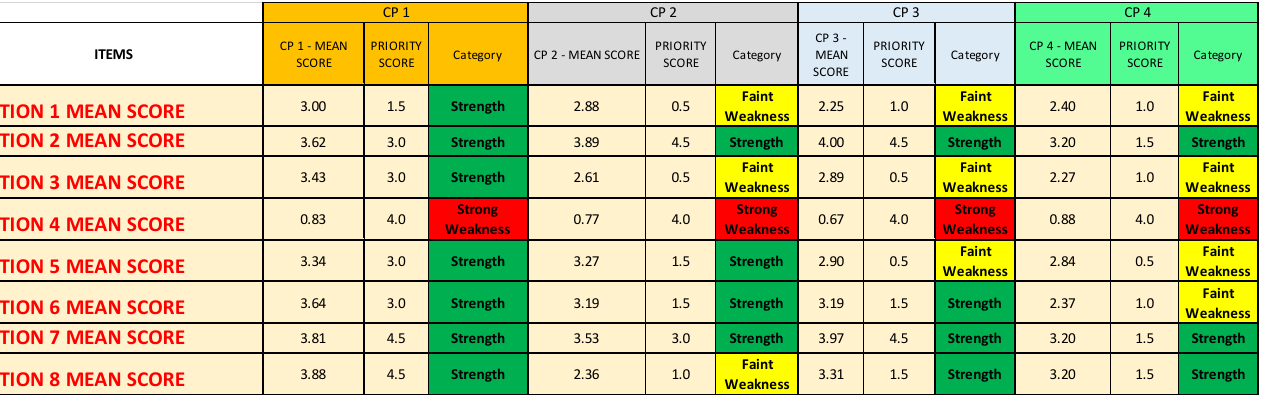
Figure 14. Summary of the results regarding all the Questionnaire Sections of the four analyzed CPs. Classification PRIORITY ITEMS CP 1 - MEAN SCORE scale SCORE Category CP 2 - MEAN SCORE Classification scale